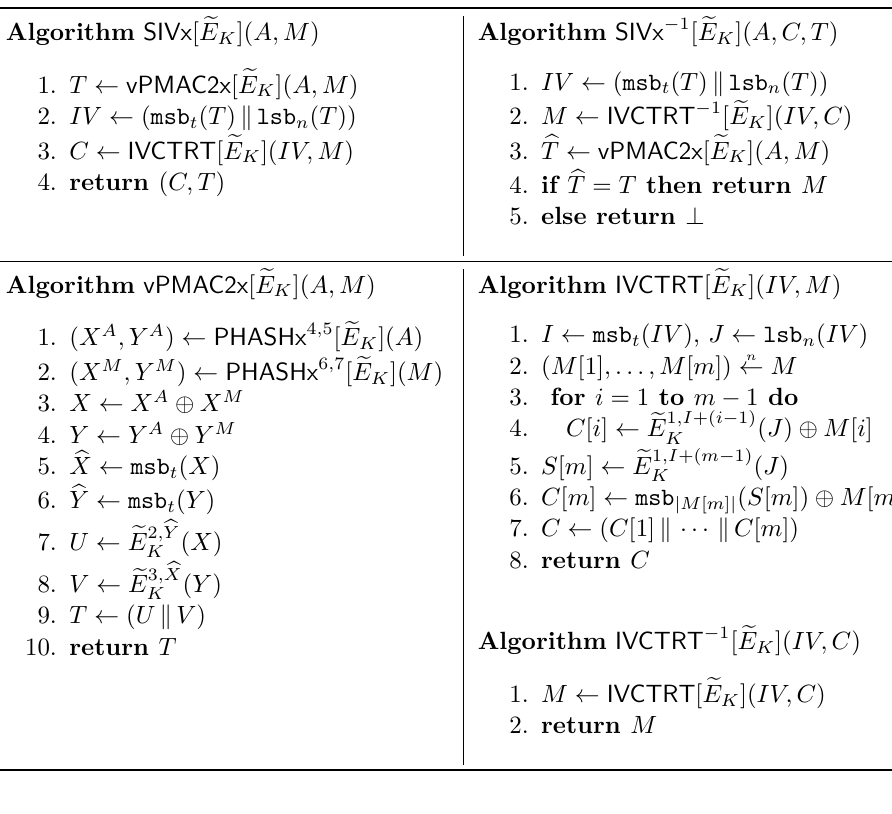
Figure 6: Definition of SIVx, following the description of [LN17]. In the above definition, PHASHx i,j [ e E K ] is a variant of PHASHx [ e E K ] defined in Fig. 1 where e E i, ∗